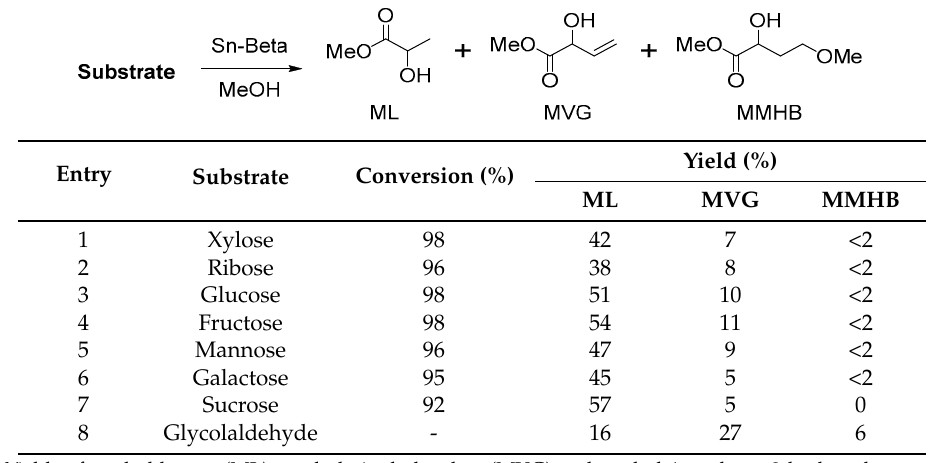
Table 1. Conversion of various sugars in methanol using Sn-Beta 1 .